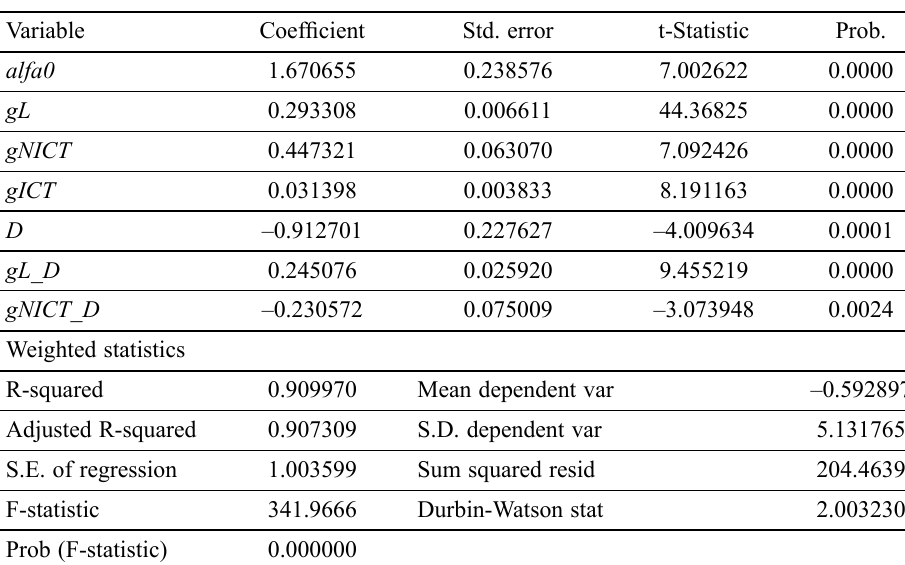
Table 4. Estimation of the production function model of the EU-14 countries Dependent variable: GGDP